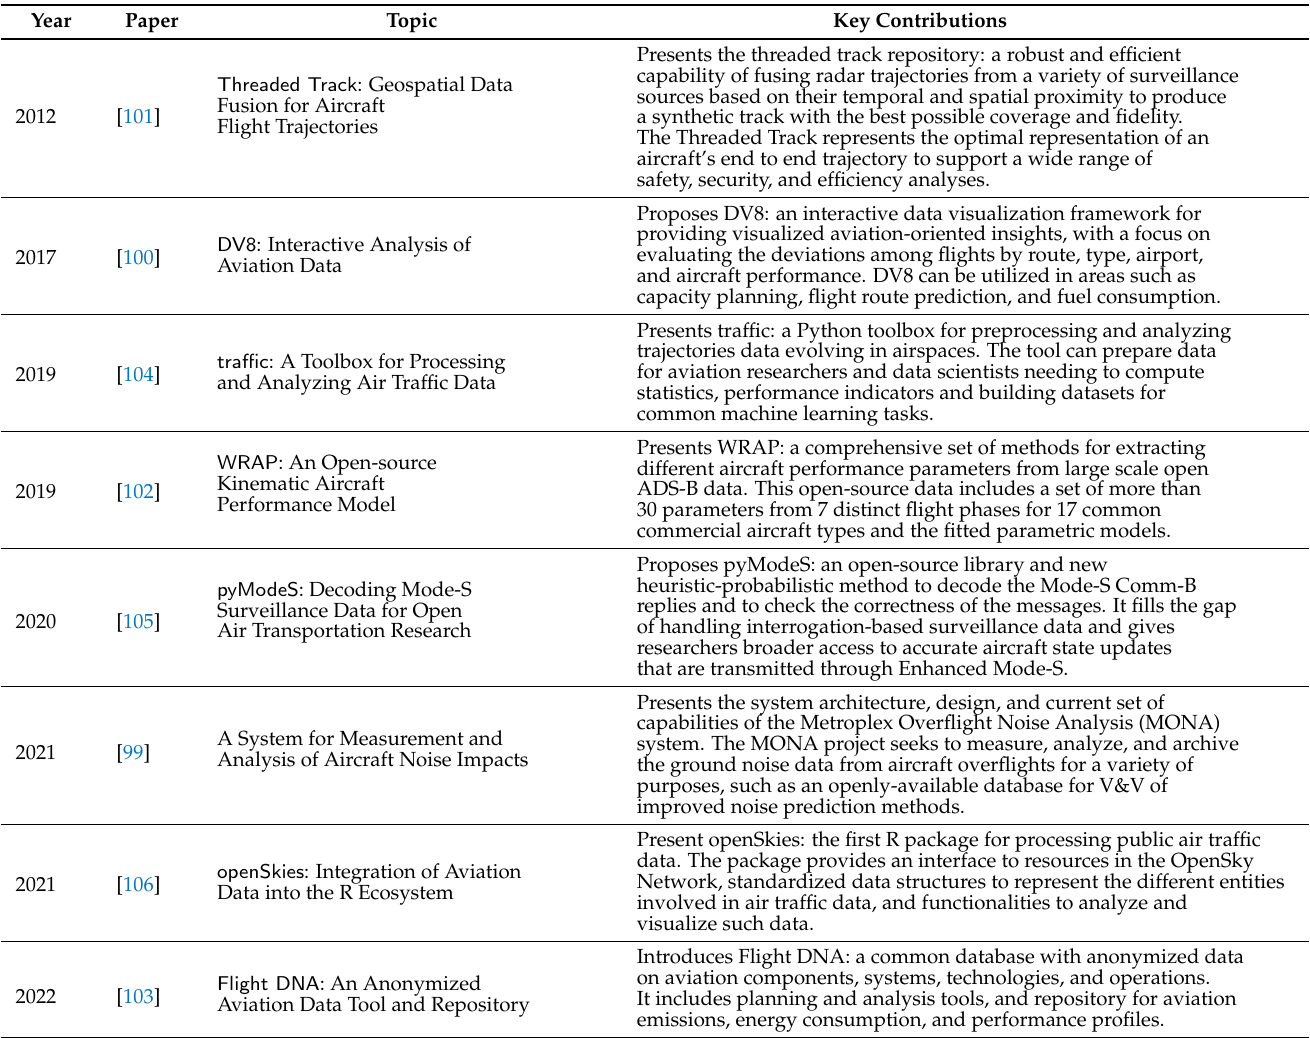
Table 8. Summary of representative papers in infrastructure and